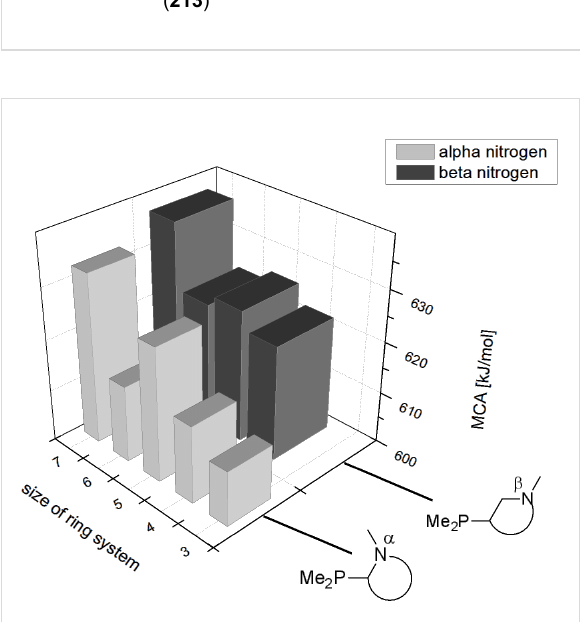
Figure 7: MCA values of phosphanes PMe 2 R connected to α , α - and β , β -position of nitrogen containing cyclic